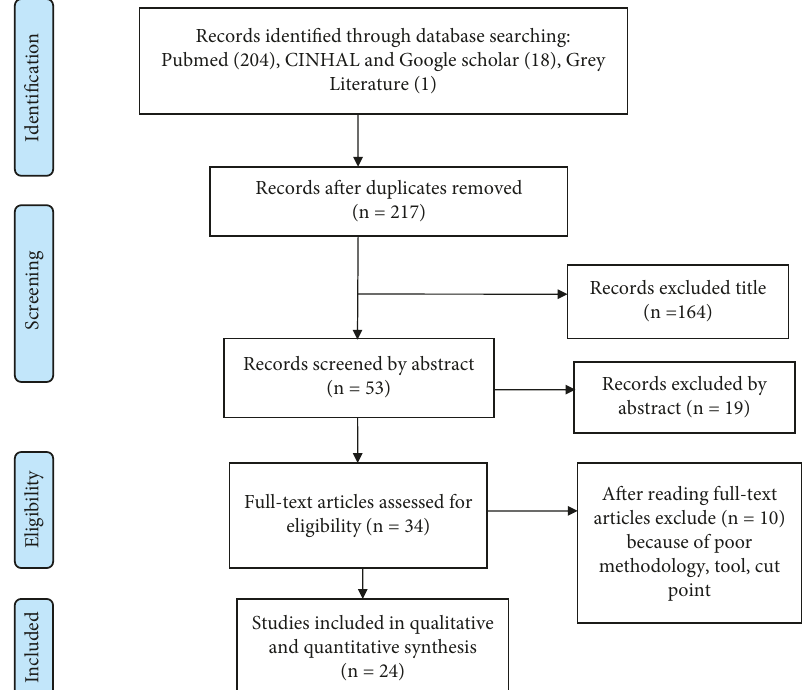
Figure 1: PRISMA flow diagram that shows study selection for meta-analysis of self-care adherence for hypertensive